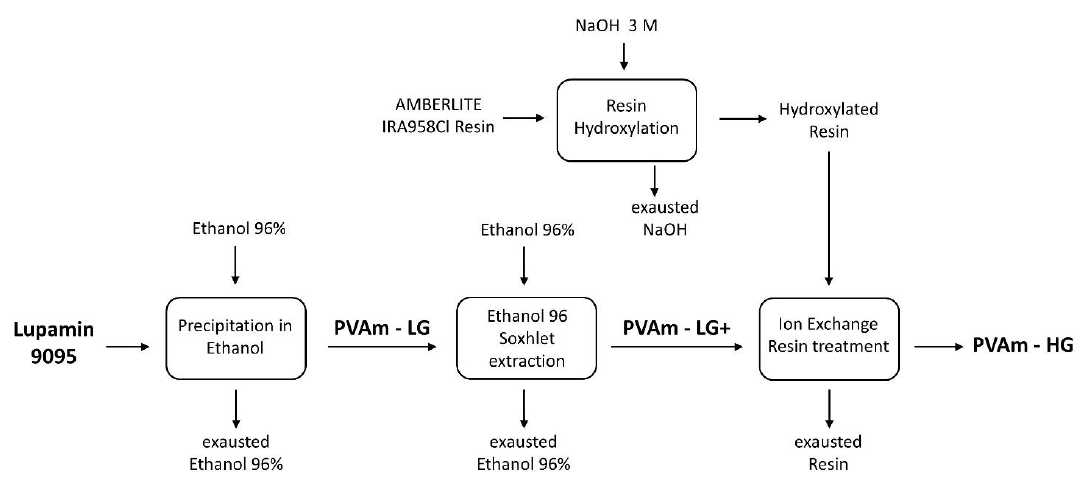
Figure 3. Scheme adopted for commercial Lupamin 9095 purification.